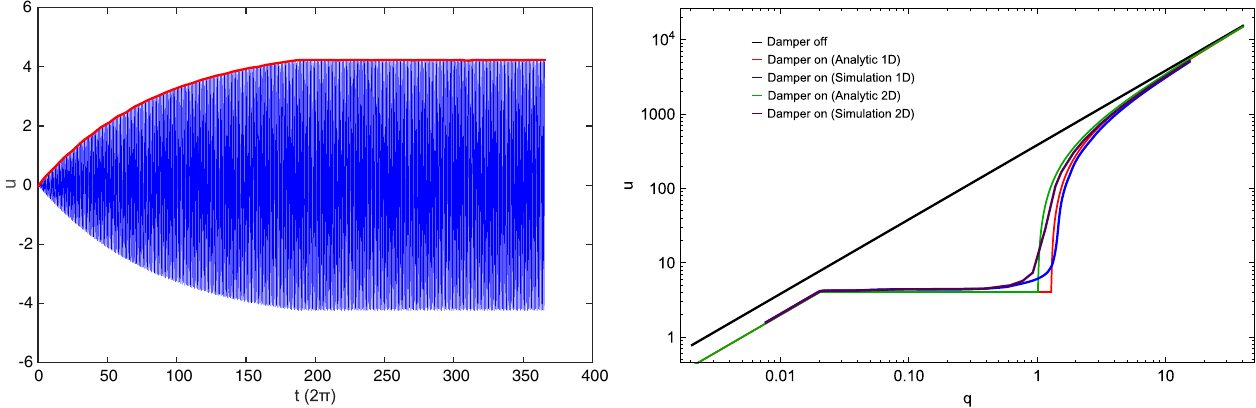
FIG. 6. Left: Transient response at q ¼ 0 . 15 varying with time — the envelope is marked in red; right: simulation responses (1D and 2D) with the damper on — plots are added to Fig. 4 with a scale factor of ϕ d μ N=k 1 and ϕ d μ N